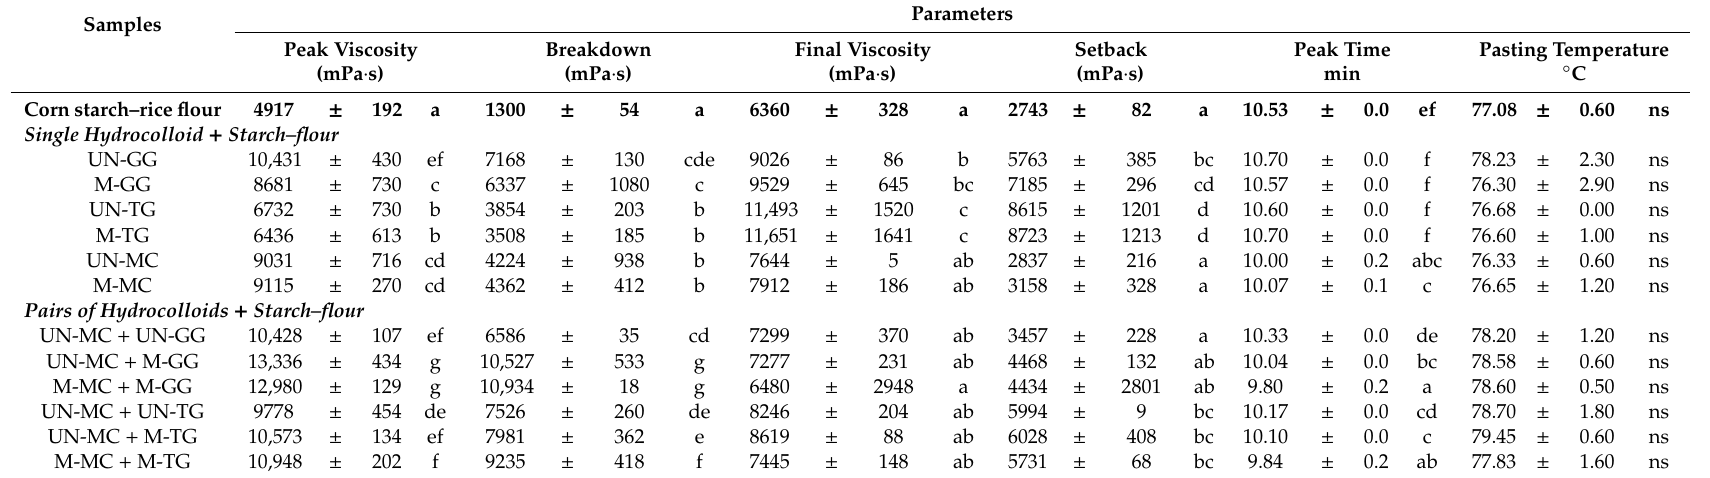
Table 2. Viscometric parameters of corn starch–rice flour systems formulated with one or two un-milled and milled